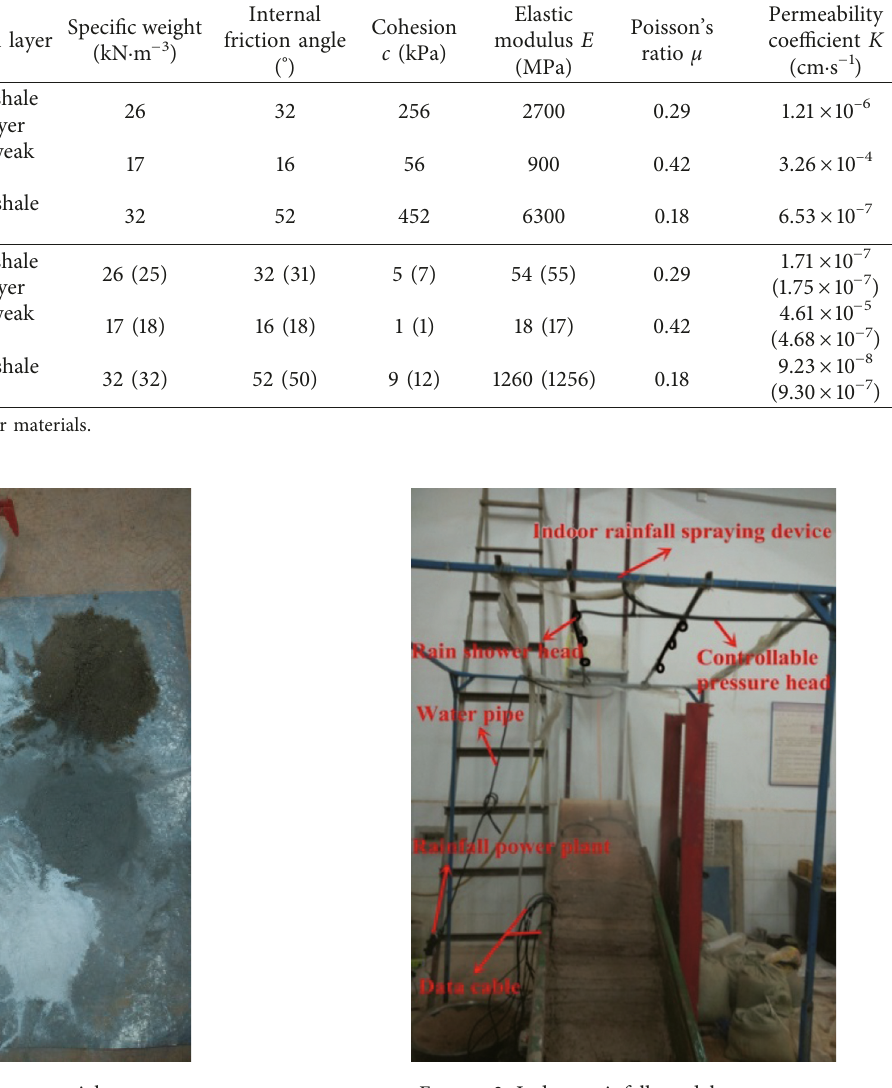
Table 4: Prototype and model slope of rock and soil mechanics parameters.